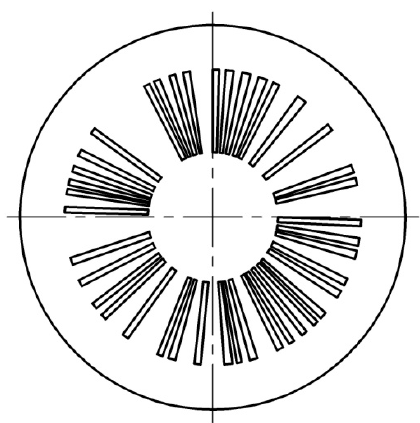
Figure 14. The system rotor disk at the number of places m = 276 and the random distribution of the windows under the residual cyclical quadratic chain code.